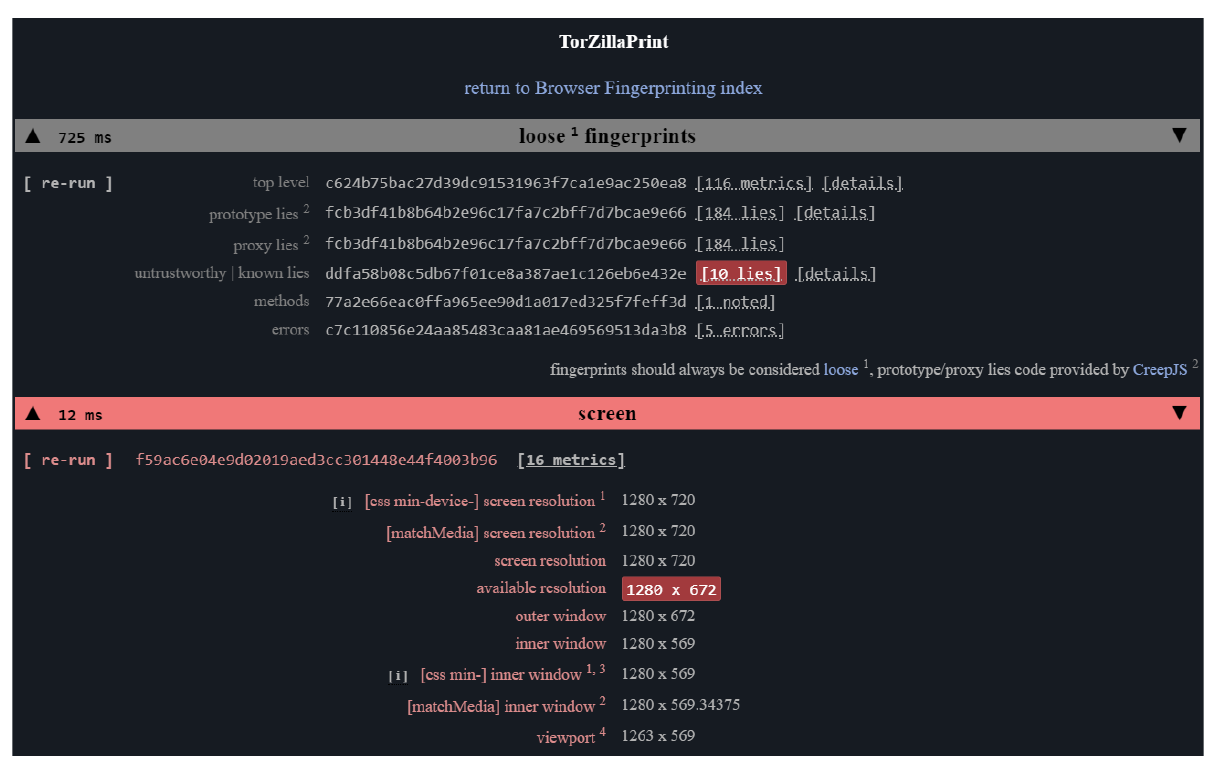
Figure 5. Snapshot of the website built.